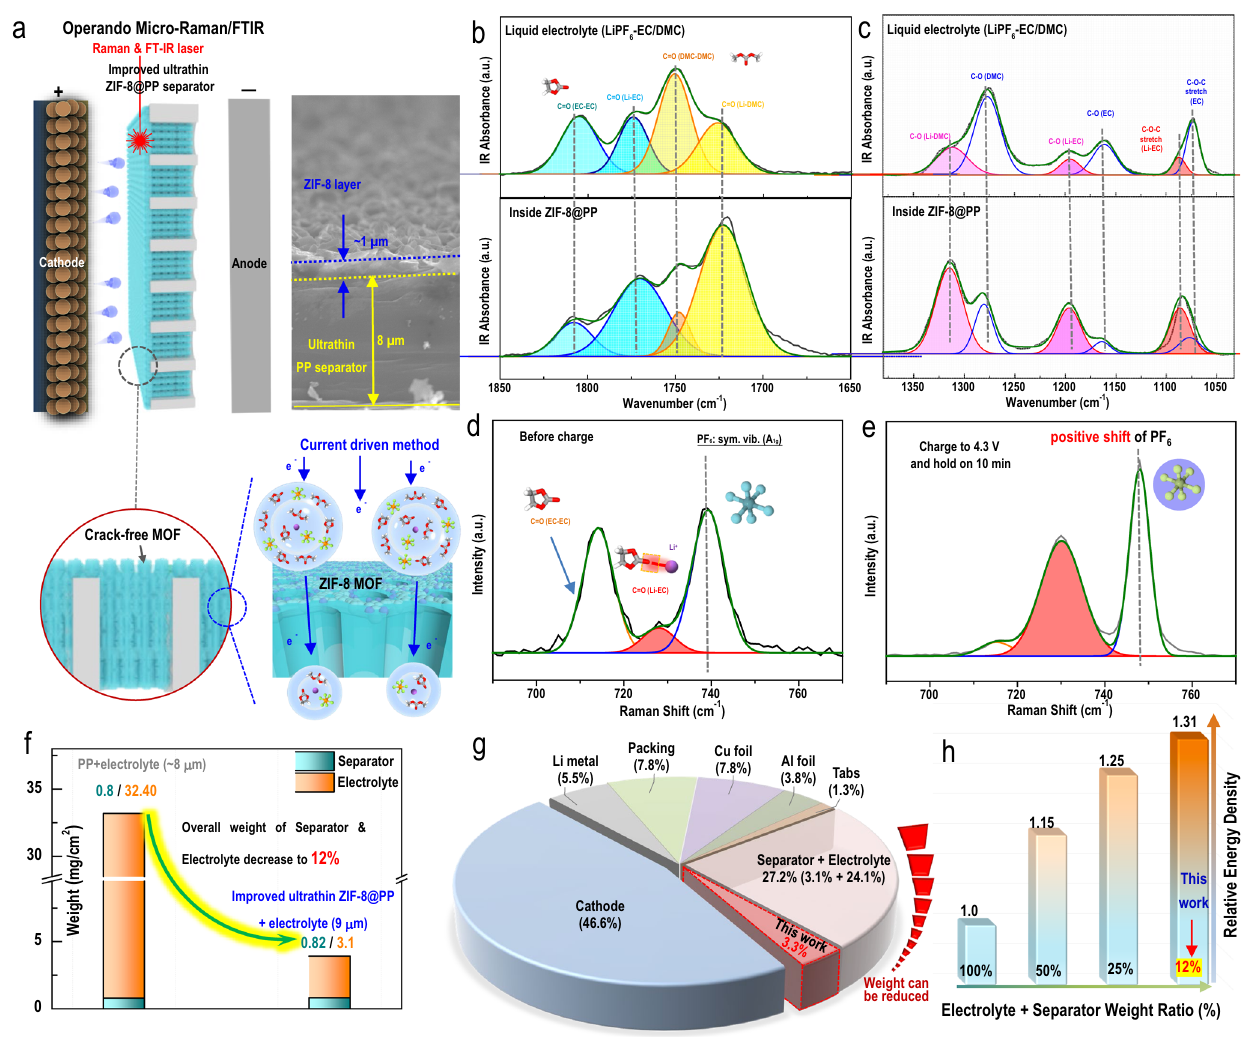
Fig. 4 | Physicochemical properties of the improved ultrathin ZIF-8@PP separator and the liquid electrolyte inside the channels of the ZIF-8 MOF grown in-situ along the channels of the conventional ultrathin PP separator. a Schematic representation of the operando micro-Raman and attenuated total re fl ection – Fourier transform infrared (ATR-FTIR) techniques employed to char- acterize the liquid electrolyte con fi ned inside the ZIF-8 MOF grown in-situ and the proposed formation mechanism for the aggregative electrolyte con fi guration induced by the current-driven method. ATR-FTIR spectra of the typical bulk liquid electrolyte (upper panel) and electrolyte within the ZIF-8 MOF channels (lower panel)fortheranges b 1650 – 1850cm – 1 and c 1030 – 1380cm – 1